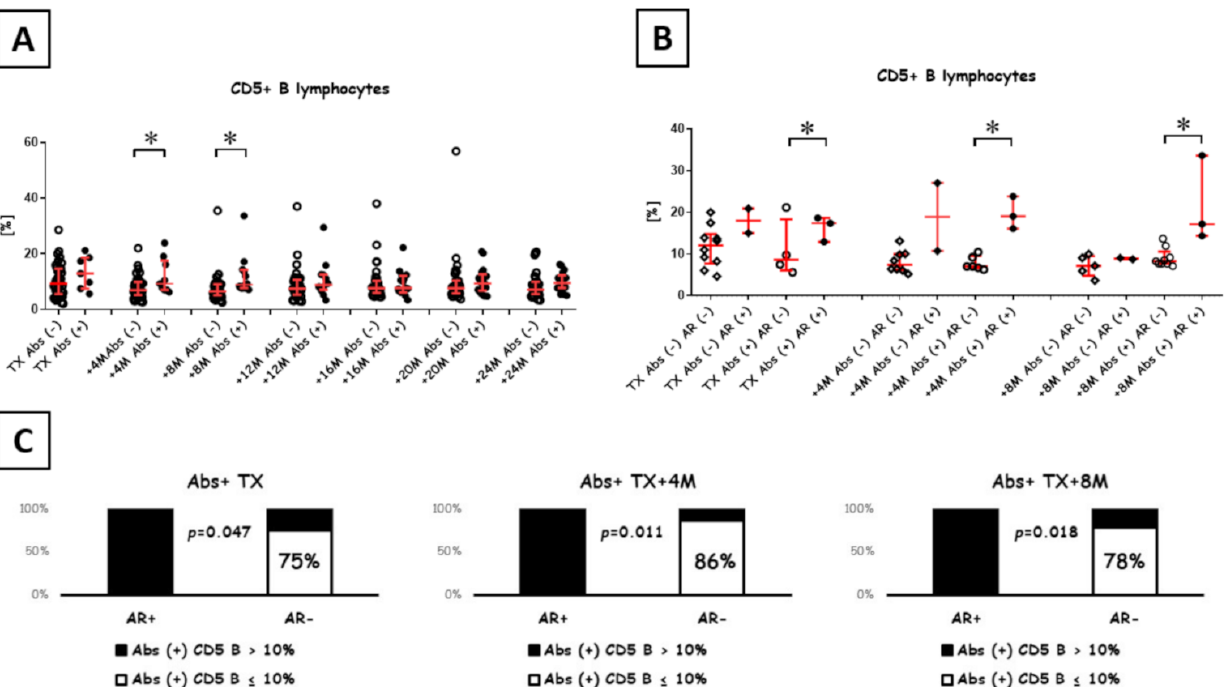
Figure 1. CD5+ B lymphocyte levels during the first 2 y post-transplant. ( A ), a percentage of CD5+ B lymphocytes. Open circles and black circles indicate the percent of CD5+ B cells in Abs- and Abs+ patients, respectively. The two groups were compared at each follow-up time point, starting from kidney transplant to 2 y post-transplant. ( B ), a percentage of CD5+ B lymphocytes in subgroups of Abs/AR patients limited to the transplantation, 4 and 8 months after. Data were collected from 52 patients. * indicates significant differences at p < 0.05 (Mann-Whitney U test). The ratio of Abs − to Abs+ recipients at measured time points was as follows: transplant (45/7), +4 months (42/9), +8 months (40/12), +12 months (37/14), +16 months (35/15), +20 months (33/17) and +24 months (32/19). * p < 0.05 ( U tests). The ratio of Abs − to Abs+ recipients at measured time points was as follows: transplant (45/7), +4 months (42/9), +8 months (40/12), +12 months (37/14), +16 months (35/15), +20 months (33/17) and +24 months (32/19). ( C ), the ratio of AR incidents in Abs+ with CD5+ B cells above 10% limited to the transplantation, 4 and 8 months